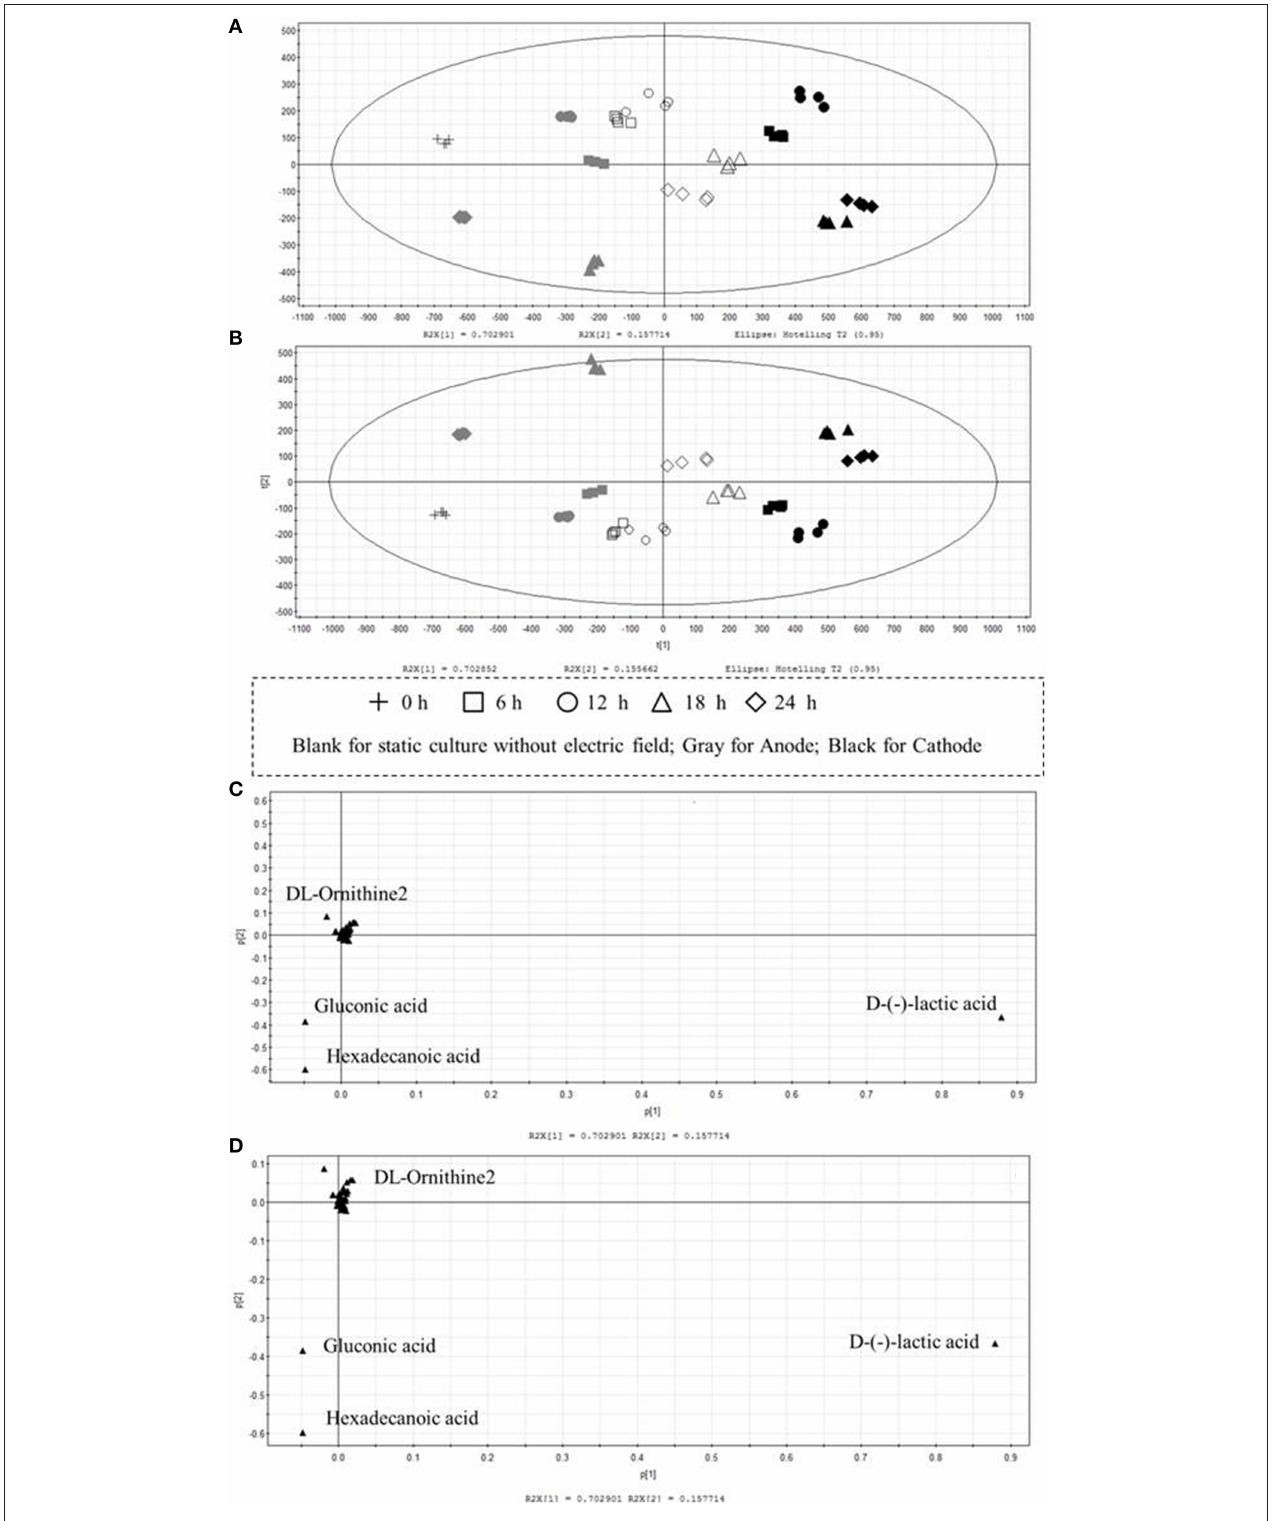
FIGURE 4 | Multivariate statistical analysis of intra-cellular metabolites of G. xylinus cultured with/without DC electric field. (Score plot A , PCA; B , PLS; Loading plot C , PCA; D , PLS). In the scores plot, the confidence interval is defined by the Hotelling’s T2 ellipse (95% confidence interval), and observations outside the confidence ellipse are considered